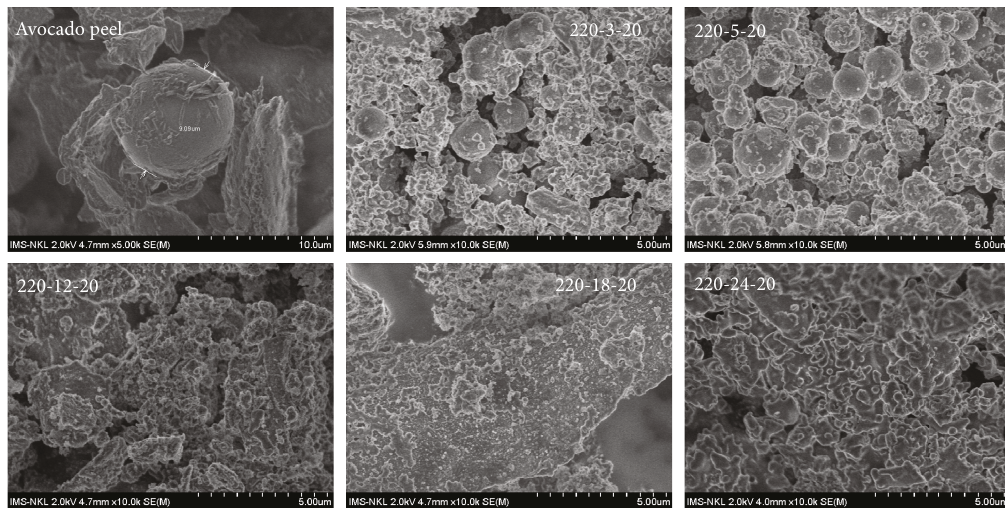
Figure 3: SEM images of hydrochars at different reaction times.